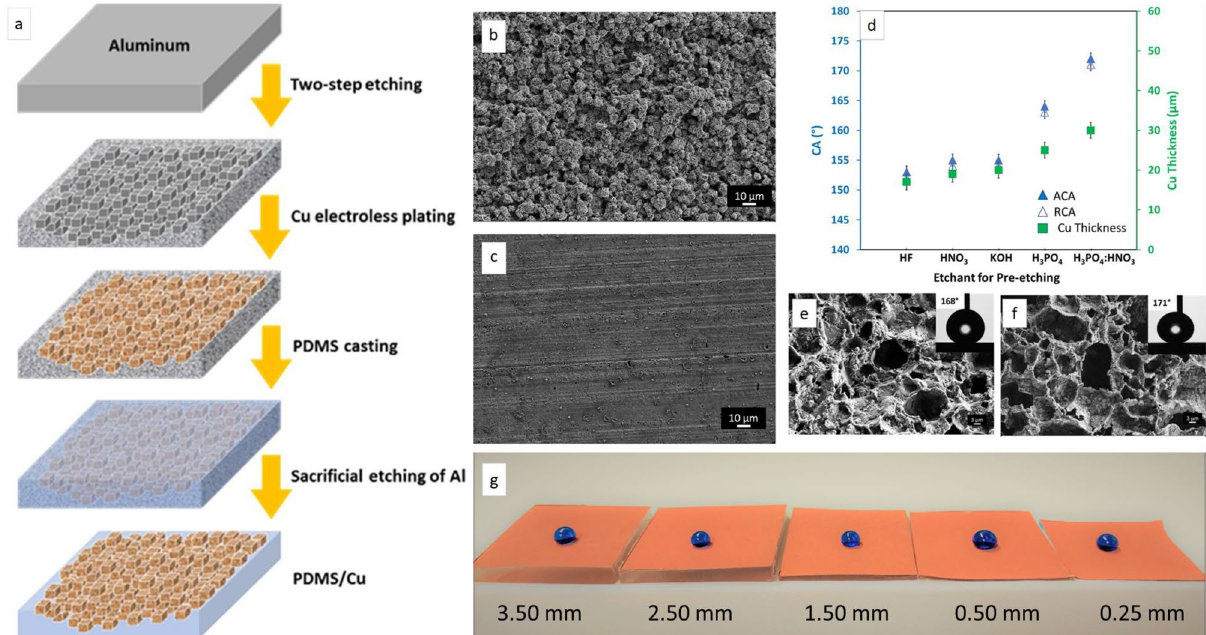
Figure 1. ( a ) Schematic illustration of the fabrication process to obtain elastic, conductive, wear-resistant superhydrophobic composite PDMS/Cu material. The SEM images of 12 min single-step HCl etched Al at two different HCl concentrations: in ( b ) 3 M HCl, microscale protrusions were obtained and ( c ) 1 M HCl showing mostly unaffected surface. ( d ) The effect of etchant types used as a pre-etching step on contact angles and plated copper thickness (1 h plating at 20 °C). The SEM images show the morphologies of the PDMS/Cu surface obtained by ( e ) one-step and ( f ) two-step etching of Al substrate and one-hour copper plating. The two-step etched sample shows richer detail of micro and nanostructures. Corresponding advancing contact angles are shown in insets. ( g ) Digital photograph of composite with different thicknesses backing layer 3.50–0.25 mm displaying water contact angle around 170°.